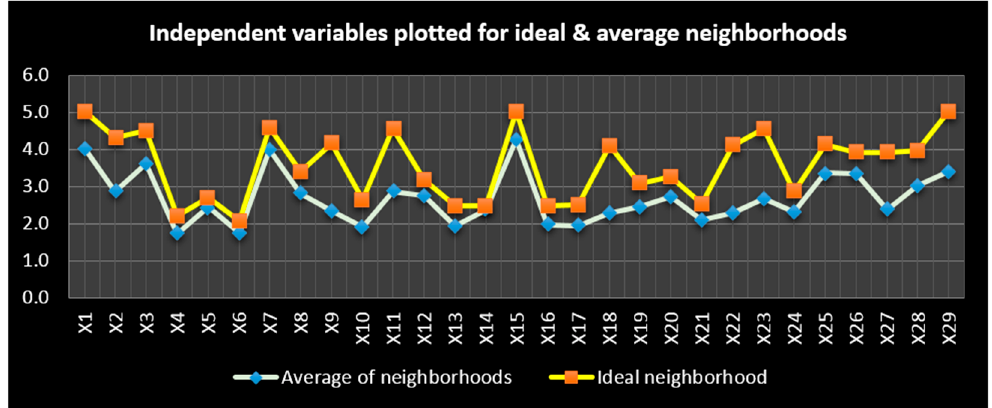
Figure 18. Showing plotting of ideal and average scores.